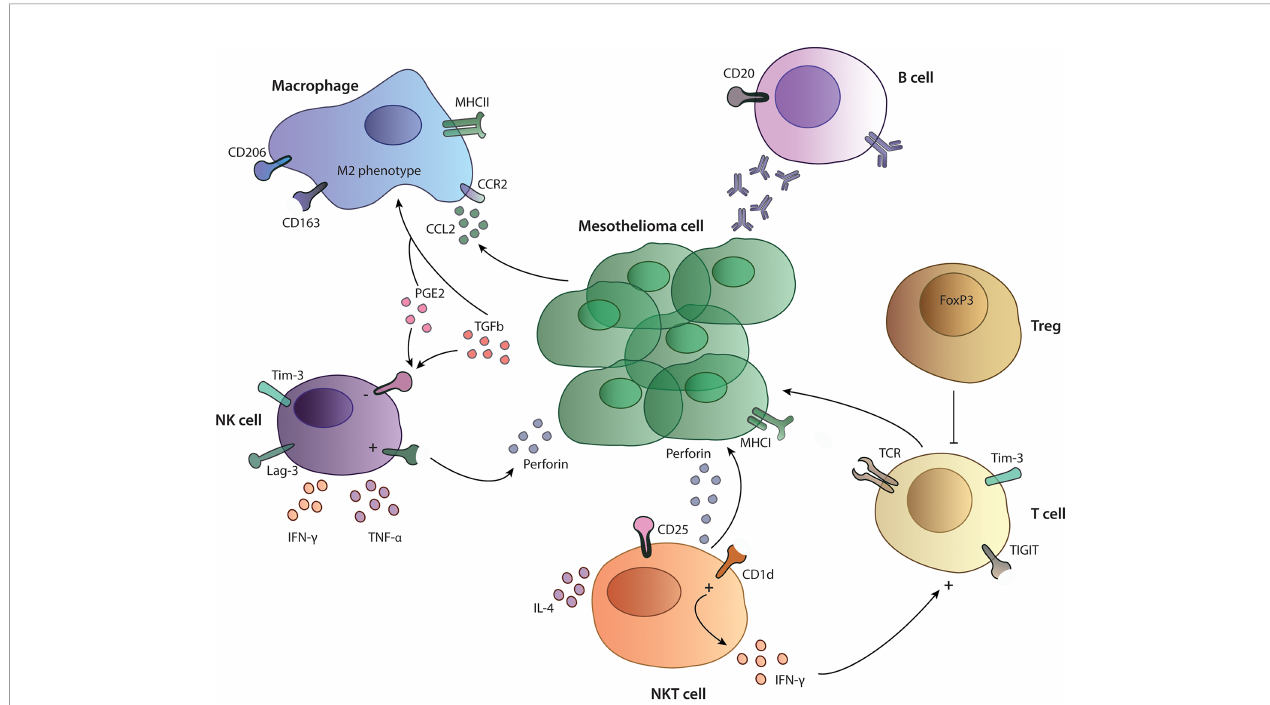
FIGURE 2 | Tumor microenvironment in mesothelioma. Overview on the functionality and interactions of different immune cells studied in MPM patients. NK cells and T cells express inhibitory receptors such as TIM-3, LAG-3 and TIGIT and are in fl uenced by a suppressive cytokines (PGE2, TGF- b ) and the presence of Treg cells in performing their cytotoxic functions. Macrophages show a M2-like phenotype with expression of CD206 and CD163 on their surface. B cells in the TME produce speci fi c antibodies against cancer cells, participating in the anti-tumor immune